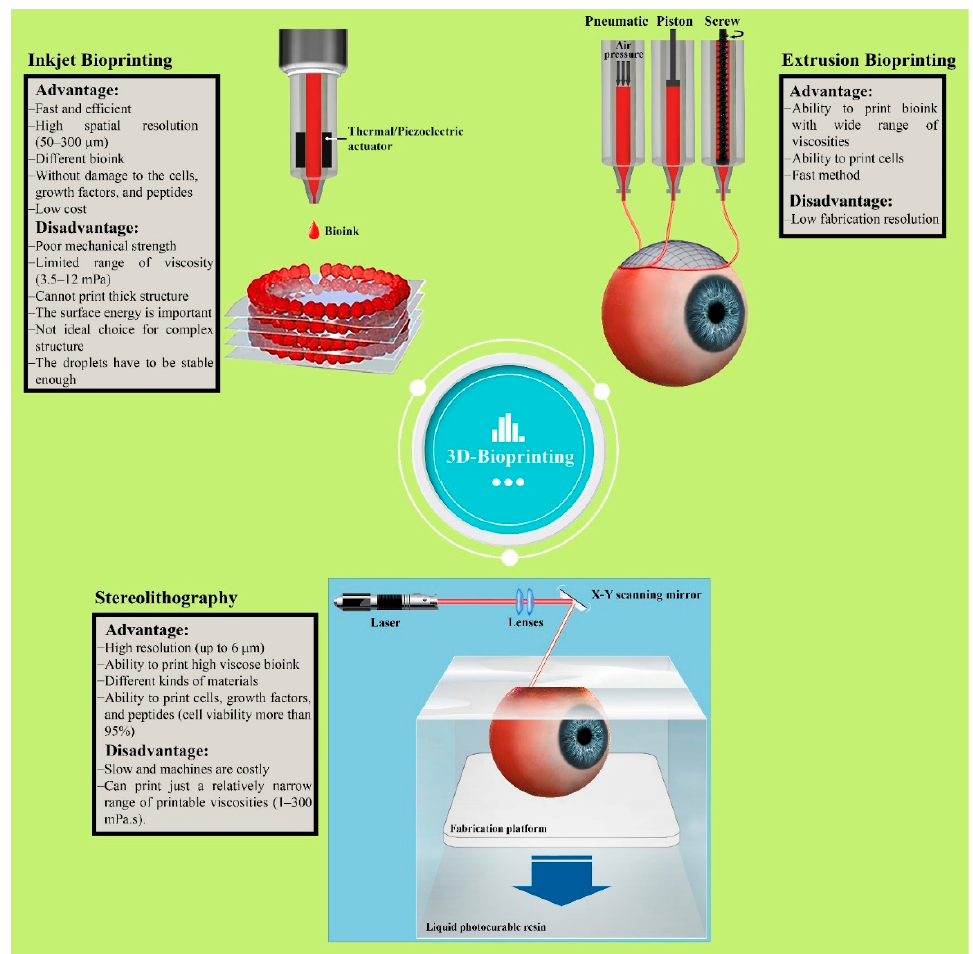
Figure 2. Schematic of different bioprinting methods with their advantage and disadvantage. Photoshop 2020 was used to create this figure.